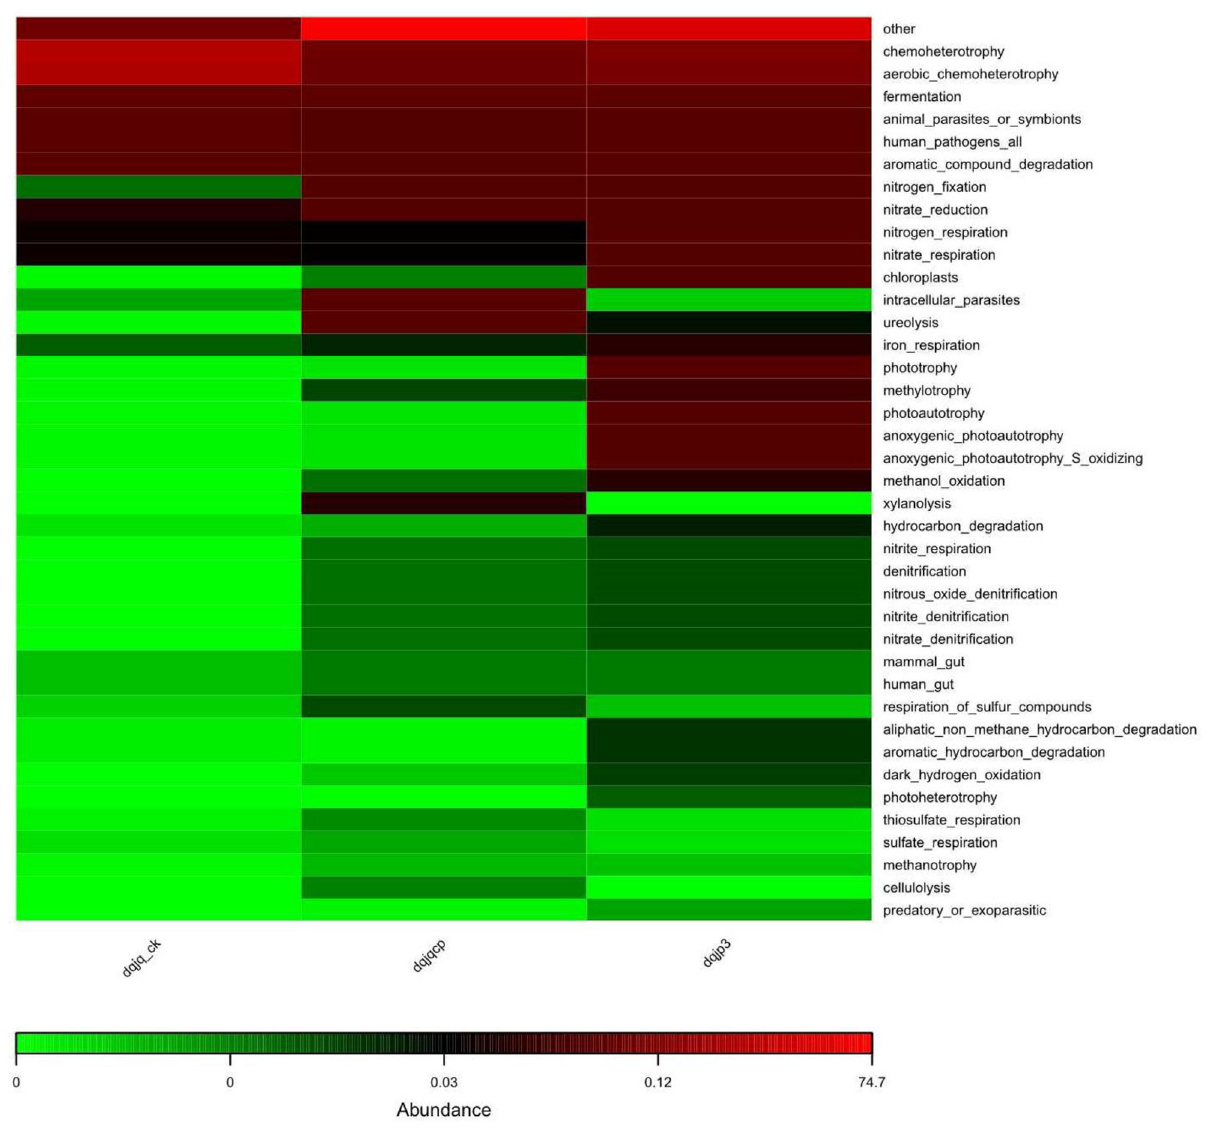
FIGURE 6 | Prediction of bacterial functional